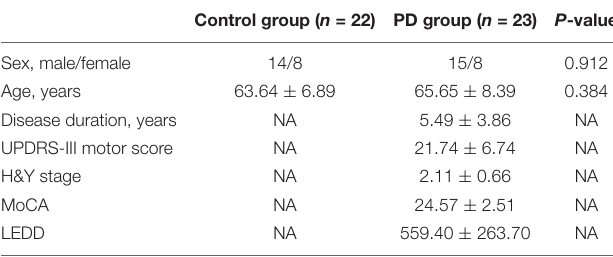
TABLE 1 | Demographics for of PD patients and healthy